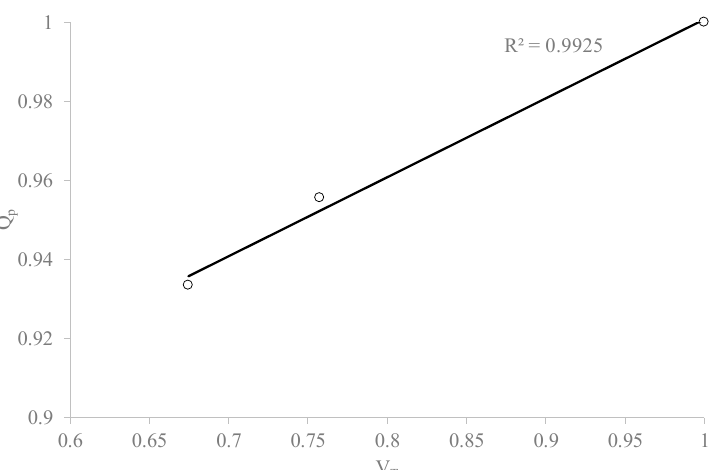
Water 2019 , 11 , 1353 Figure 11. Relationship between peak discharge and travel velocity. Figure 11. Relationship between peak discharge and travel velocity.